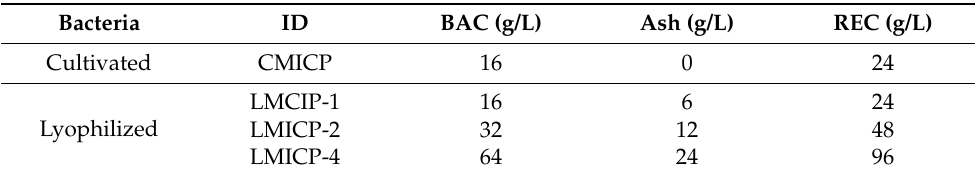
Table 1. Concentrations of CaCO 3 for in vitro tests.